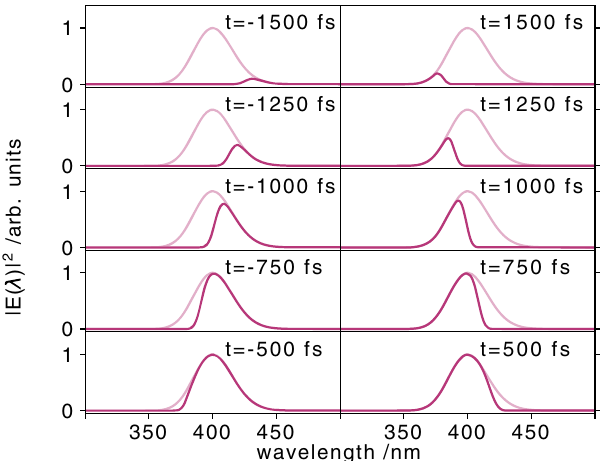
Fig.4|Calculatedself-referencedarrivaltimespectra. Simulatedself-referenced arrival time spectra for different X-ray arrival times from − 1500 fs to 1500 fs (as indicated). The arrival time spectra are shown as solid purple lines, while the full originalspectraof thetime-sheared pulseareindicated bythe shadedpurplelines. Due to the chirp of the optical pulse, the arrival time signals are not exactly sym- metric for corresponding positive and negative arrival